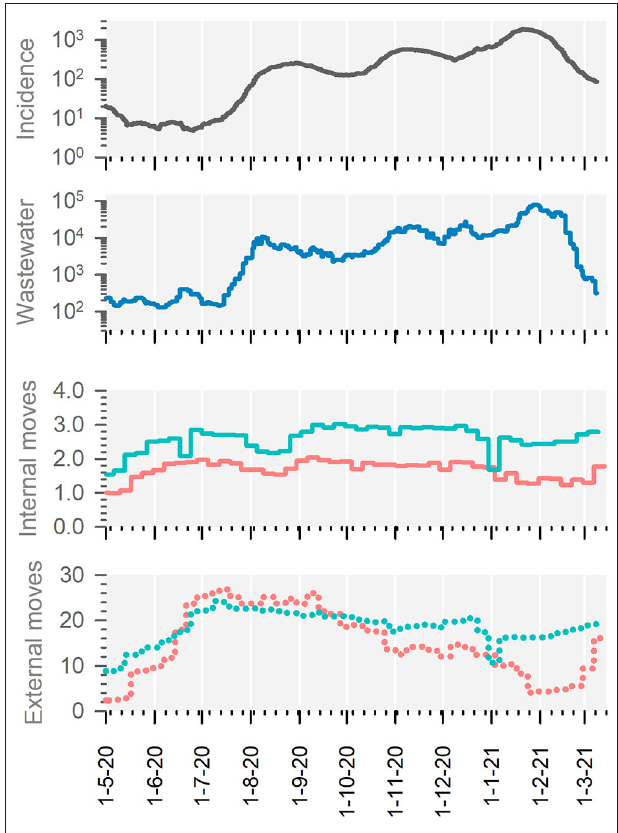
FIGURE 5 | COVID-19 incidence, SARS-CoV-2 RNA concentration in wastewaters, and population mobility records. From top to bottom: 14-day cumulative declared cases per 100,000 inhabitants; average log SARS-CoV-2 RNA concentration (gc/L) using a 14-day sliding window; publicly available population movement records within the city of Valencia (Spain) on Wednesdays (green) and Sundays (red); population movements entering or departing from the city of Valencia (Spain) recorded on Wednesdays (green) and Sundays